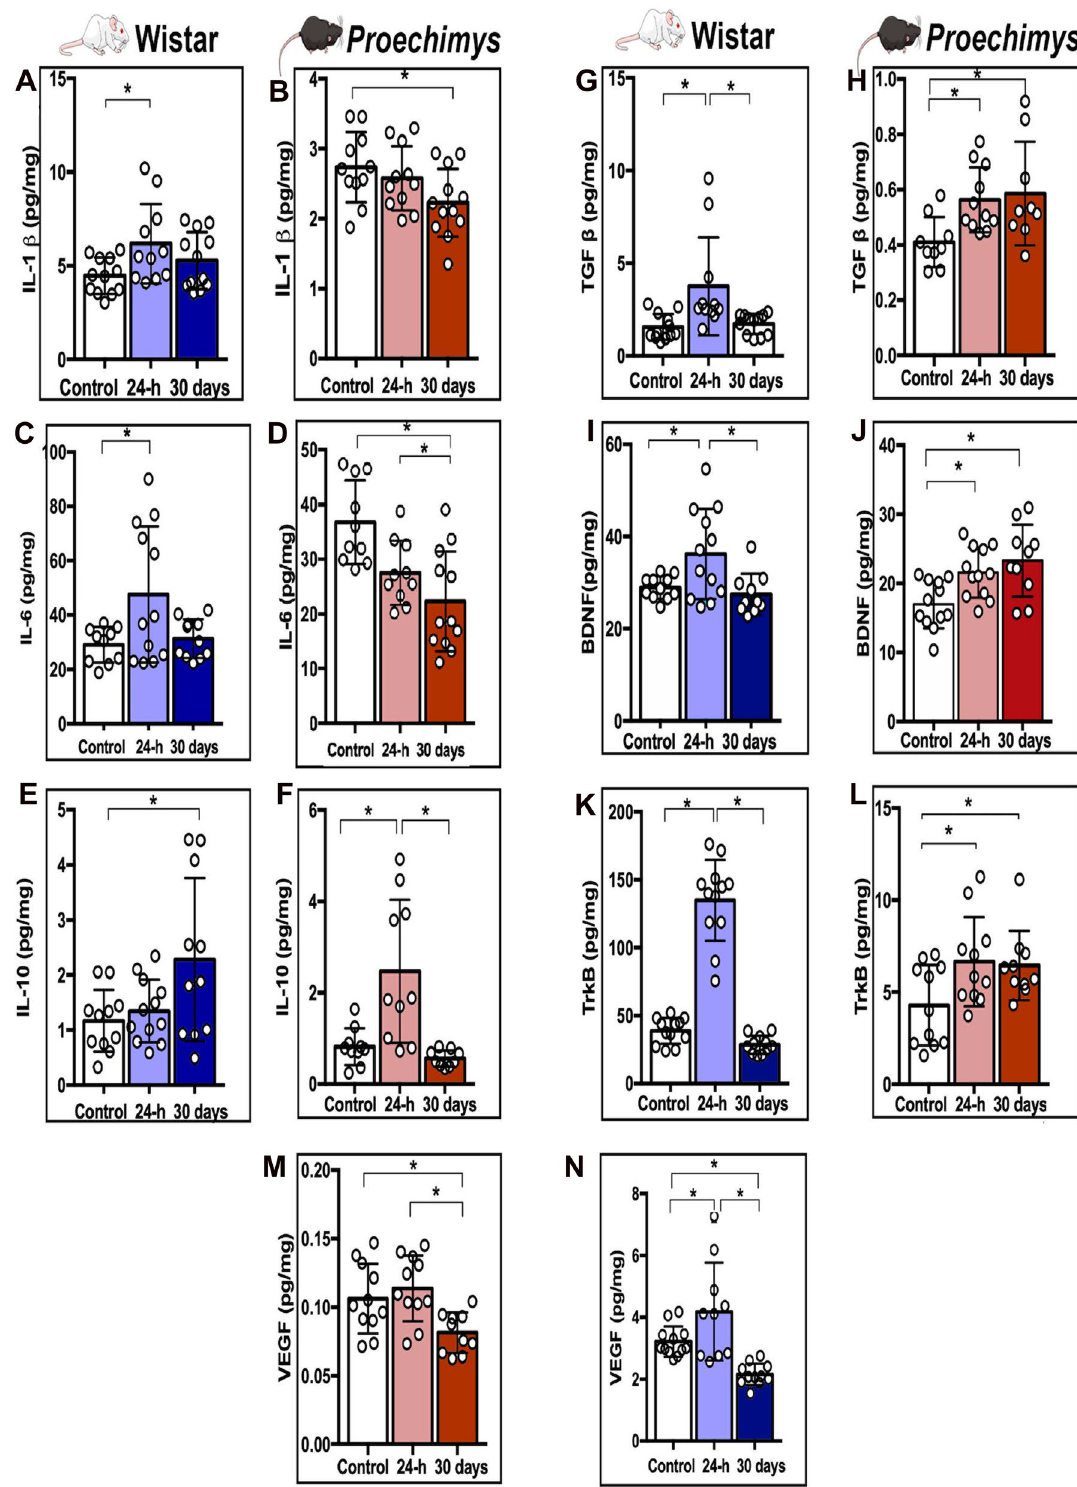
Figure 4. Brain levels of inflammatory cytokines/growth factors after photothrombosis stroke. Assessment of cytokines and chemokines analysis using multiplex assay ELISA. Bar graphs show quantification of protein levels cytokines/growth factors in the ischemic brain tissue 24-h and 30 days after photothrombosis stroke vs. control. One-way ANOVA followed by Tukey test. *p < 0.05. Graph bars show mean ± SD. ( A,B ) IL-1β levels Wistar ( A ) and Proechimys groups ( B ). ( C , D ) IL-6 levels in Wistar ( C ) and Proechimys group ( D ). ( E , F ) IL-10 levels in Wistar group ( E ) and Proechimys group ( F ). ( G , H ) TGF-β levels in Wistar ( G ) and Proechimys group ( H ). ( I , J ) BDNF levels in Wistar ( I ) and Proechimys group ( J ). ( K , L ) TrkB levels in Wistar group ( K ) and Proechimys group ( L ). ( N , M ) VEGF levels in Wistar group ( N ) and Proechimys group ( M